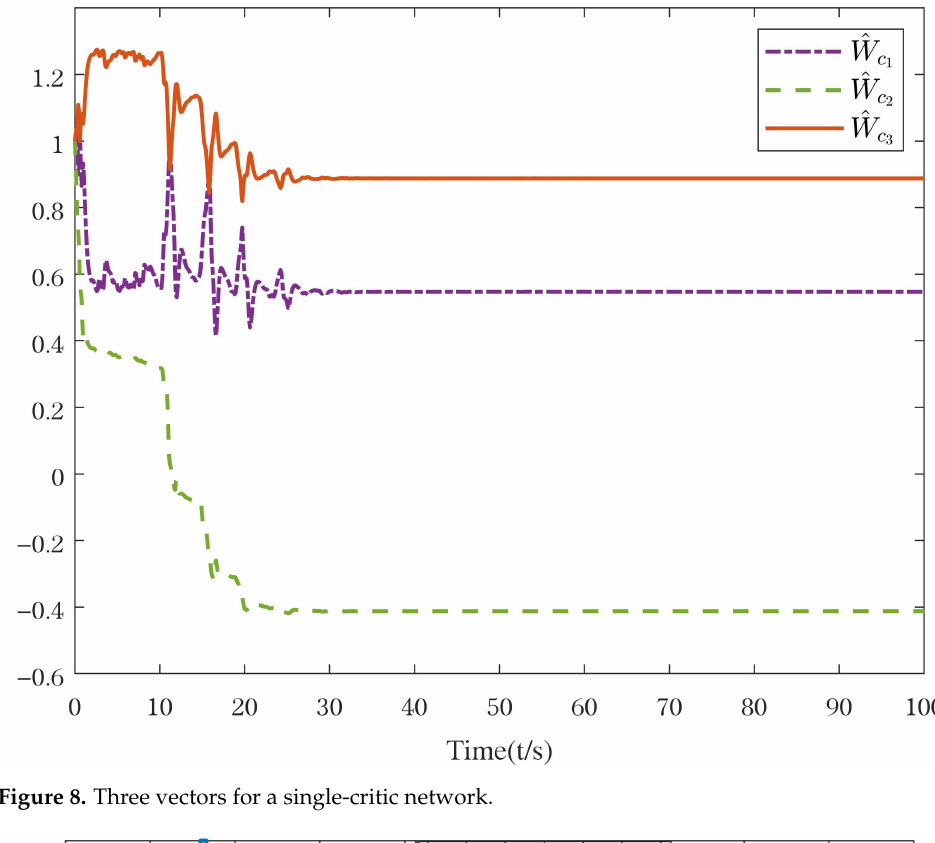
Figure 8. Three vectors for a single-critic network.